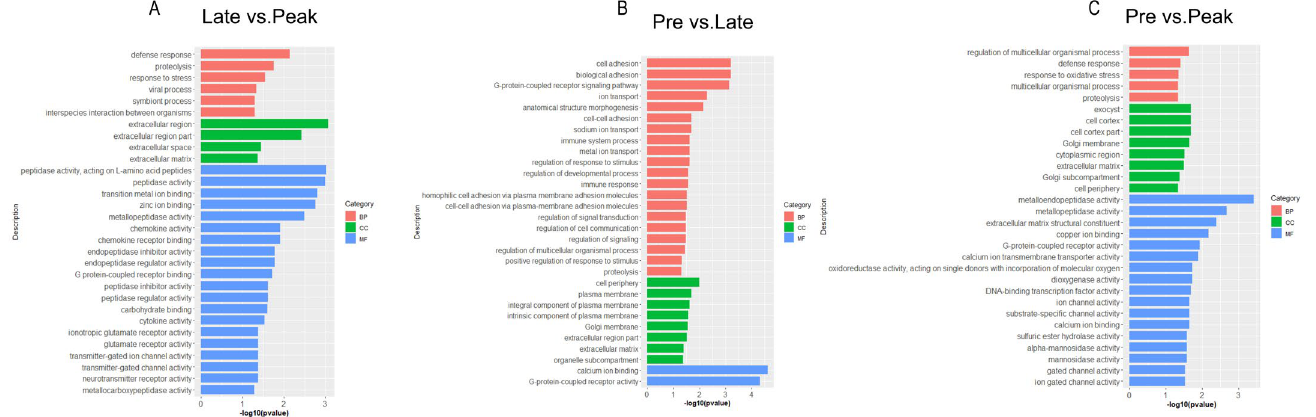
Figure 3. The GO enrichment bar graphs for the top 30 items in the ( A ) late vs. peak stage, ( B ) pre vs. late stage, and ( C ) pre vs. peak stage. (BP: biological process, CC: cellular component, MF: molecular